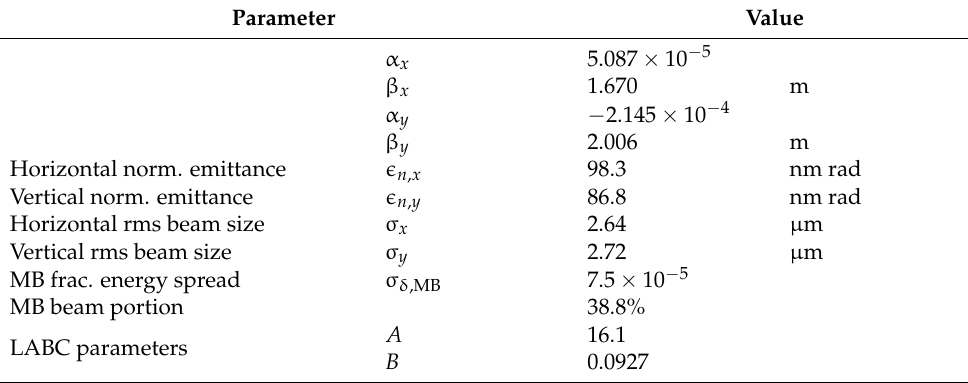
Table 8. Lattice 1 electron beam Twiss parameters and other properties at X-ray undulator entrance. Beam energy 12 GeV.